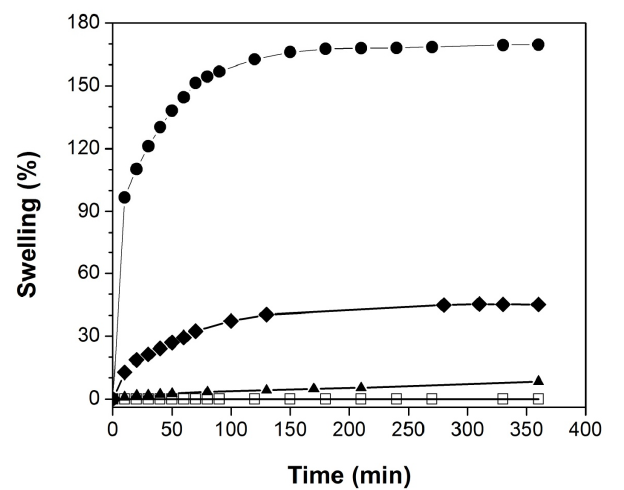
Figure 3. Swelling kinetics of PNVCL and PNVIM onto SR films graft contents of SR alone (  ), SR-g-NVCL 29% graft ( ▲ ), SR-g-(NVCL-co-NVIM) 75% graft ( ◆) , and SR-g-NVIM 106% graft (  ) immersed in water at 25